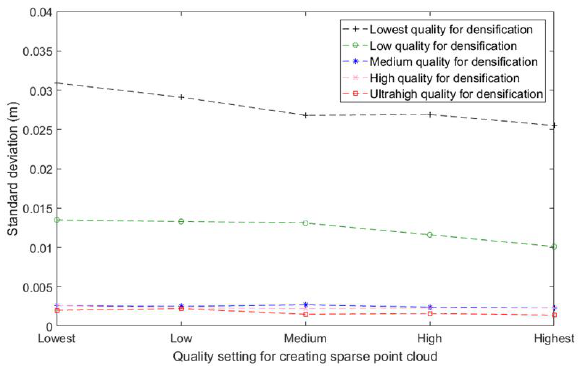
Figure 2. The precision of the SfM-derived point clouds at different quality settings